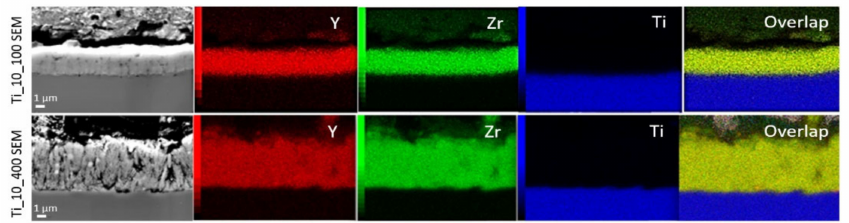
Figure 6. Distributions of map elements for deposited coatings. Scale bar = 1 µ m.